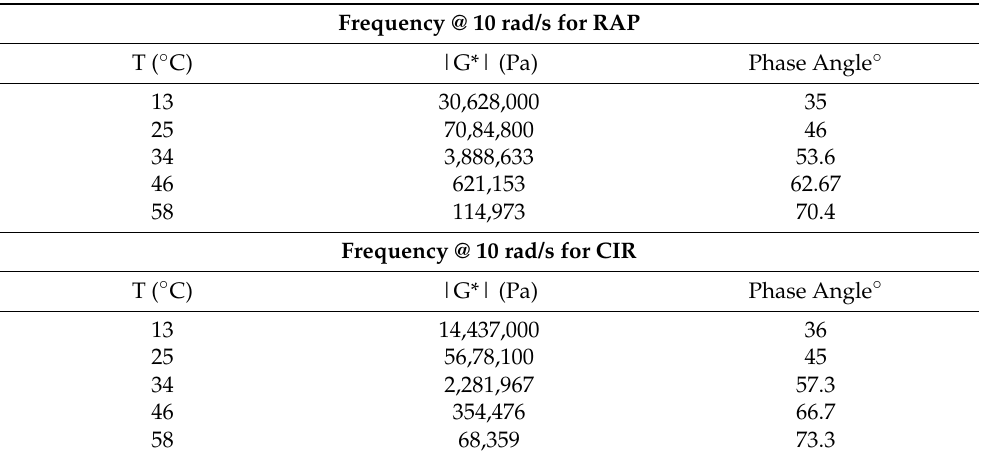
Table 3. DSR results of RAP and CIR used in this study.